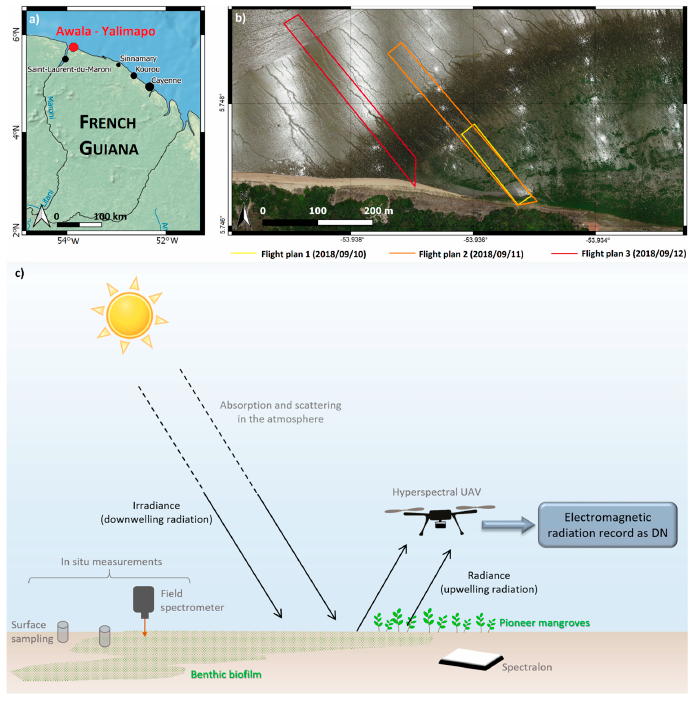
Figure 1. ( a ) Localization of the study area in Awala-Yalimapo in the western part of French Guiana. ( b ) UAV flight plans above the study area, designed to capture the various mud facies (from bare mud to mangrove stages). ( c ) Diagram of a survey setup and the physical variables to be measured.